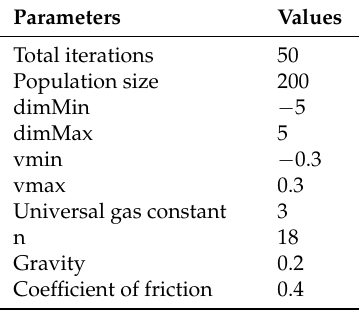
Table 7. Parameters of WDO.